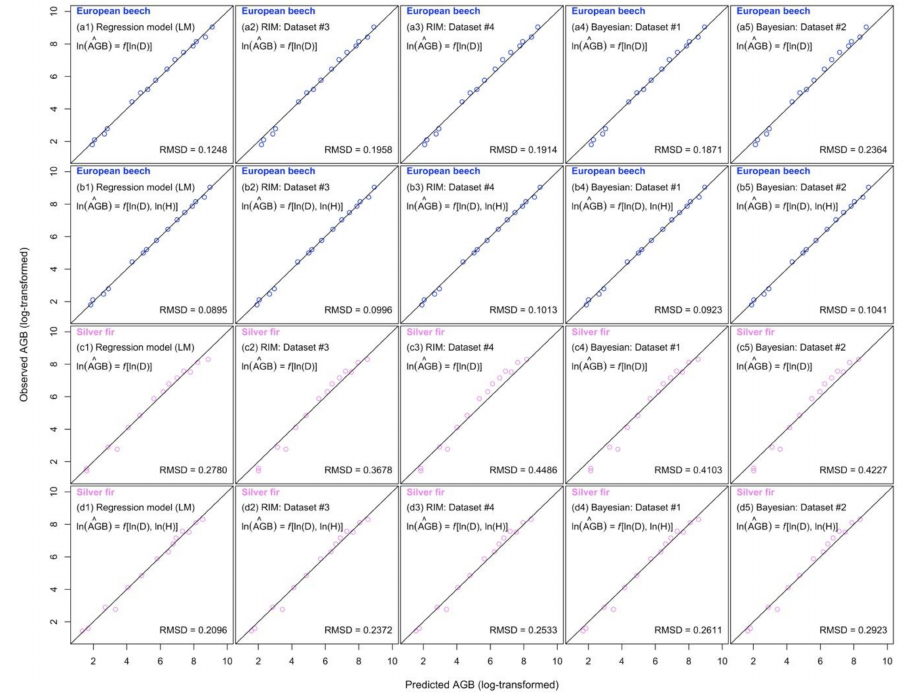
Figure 1. The observed ln(AGB) against the predicted ln(AGB). Note: AGB is the aboveground biomass; the values are presented in log-scale for two species, two predictor combination, and five fitting approaches. The data used for validation is from Dataset #1. LM is the linear regression model on log-transformed data (Section 2.2.1); RIM is the random intercept model (Section 2.2.2); ln(D) is the logarithm of diameter at breast height; ln(H) is the logarithm of tree height; ln(AGB) is the logarithm of aboveground biomass; RMSD is the root mean squared deviation (Section